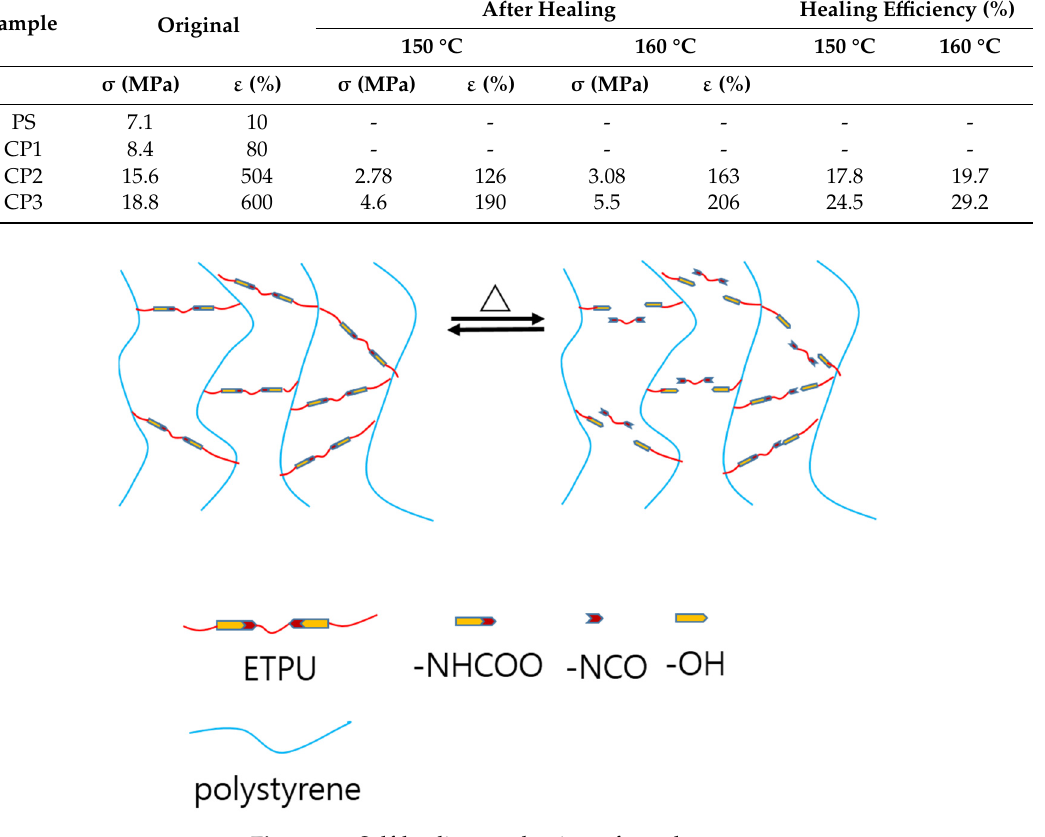
Figure 12. Self-healing mechanism of copolymers.